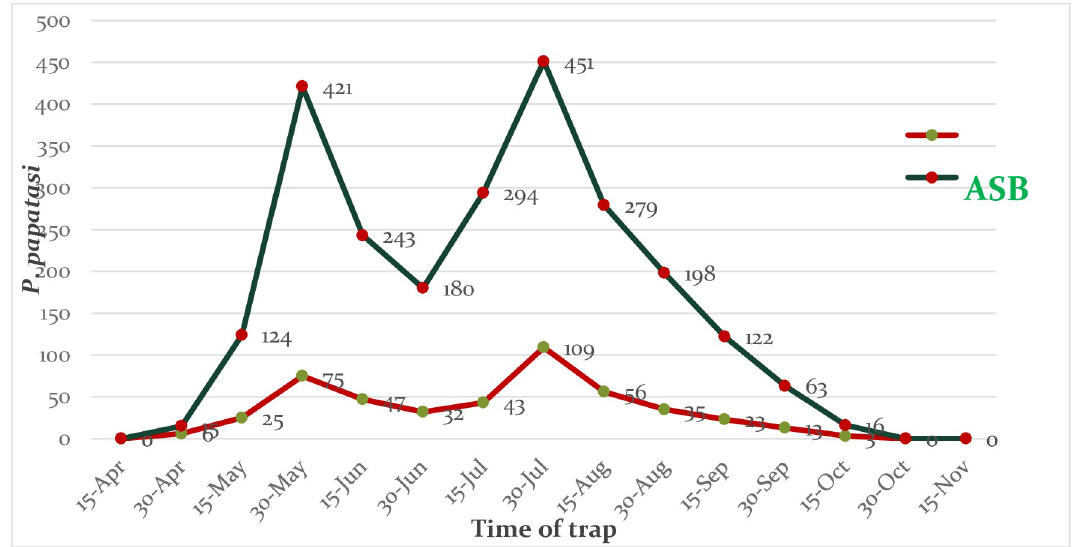
https://doi.org/10.1371/journal.pone.0173558.g002